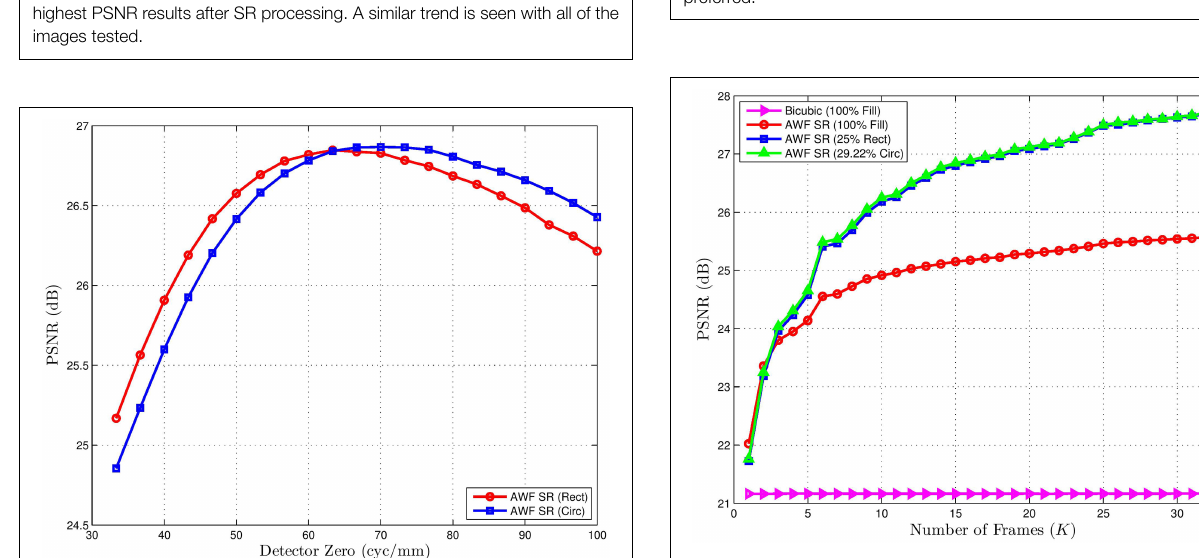
FIGURE 24 | PSNR for K = 16 multiframe AWF SR for the 8 bit motocross image (kodim05.png) vs. the detector zero frequency. The system parameters are the Q = 0 . 50 row in Table 1 , except a and b are changed to control the detector zero location here. The detector zero frequency ranges from 1 / p to 1 . 5 / ( pQ ) . Note that the peaks occur very close to the optical cutoff frequency 1 / ( pQ ) = 66 . 67 cyc/mm.